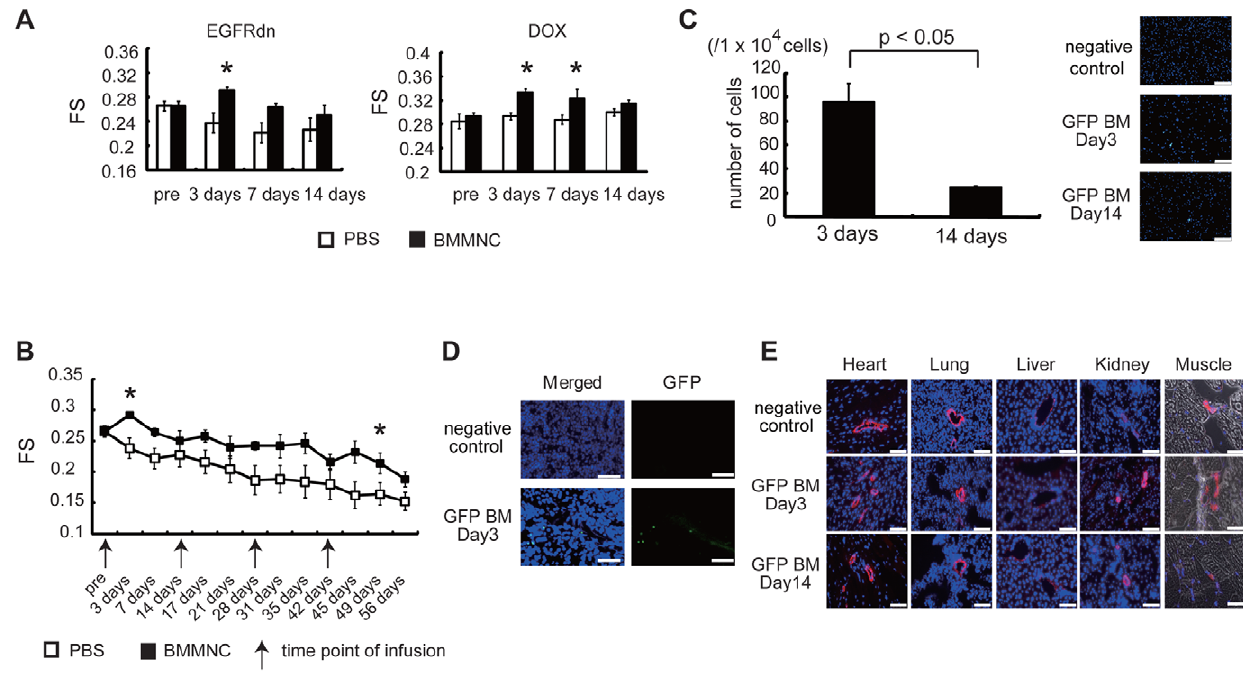
Figure 2. BMMNC infusion transiently improved the cardiac function of DCM mice. (A) Echocardiographic analysis. Transient improvements of FS were observed at 3 d in the BMMNC-treated group, but not the control (PBS) group, in EGFRdn mice (left), and at 3 and 7 d in DOX-treated mice (right). * p , 0.05 versus PBS ( n =8 per group). (B) Repeated-infusion experiments. BMMNC were infused every 2 weeks. A similar pattern of improvement in FS was observed after each infusion. * p , 0.05 versus PBS ( n =8 per group). (C–E) Immunohistochemical analysis. (C) Left, the number of GFP-positive BMMNC in peripheral blood ( n =3). Right, photomicrographs of peripheral blood. Nuclei were stained with Hoechst 33258 (blue). Scale bars, 75 m m. (D) Images of the spleen 3 d after infusion. Many GFP-positive cells were observed in the spleen (lower photographs). Upper photographs, negative control. Nuclei were stained with Hoechst (blue color). Scale bars, 25 m m. (E) No GFP-positive cells were observed in any organs. Upper photographs, negative control. Middle and lower photographs, images taken at 3 and 14 d, respectively, after infusion. The vessels were stained with smooth muscle cell actin (red). Nuclei were stained with Hoechst 33258 (blue). The photographs of muscle are merged fluorescent and phase-contrast images. Scale bars, 75 m m. Data are means 6